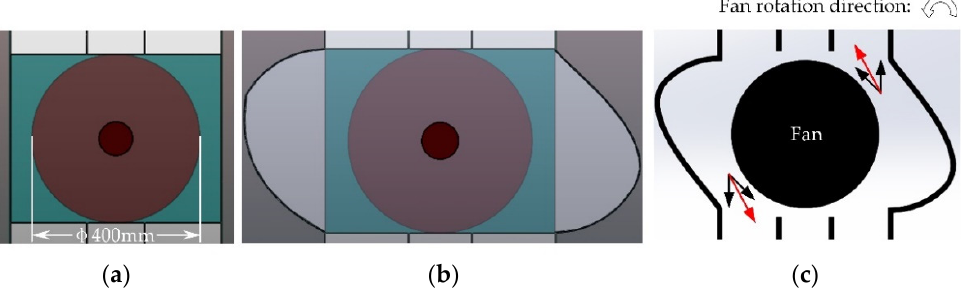
Figure 7. Optimized scheme 3: ( a ) before optimization; ( b ) after optimization; ( c ) flow direction.